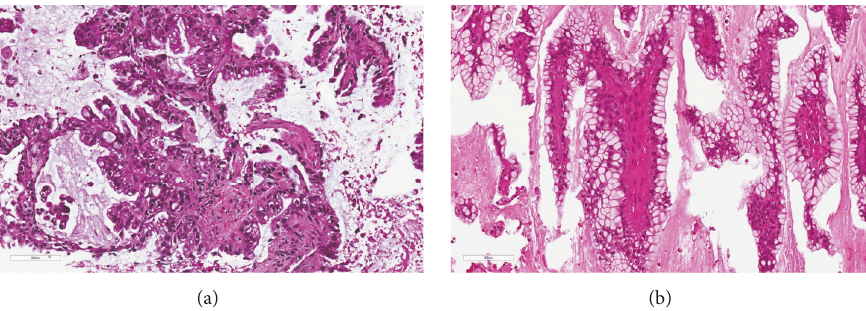
Figure 4: Both lung (a) and (b) skull bone and dura specimens demonstrating infiltrative glandular epithelium with intracytoplasmic mucin and hyperchromatic nuclei, some showing prominent nucleoli (hematoxylin & eosin, magnification × 200).